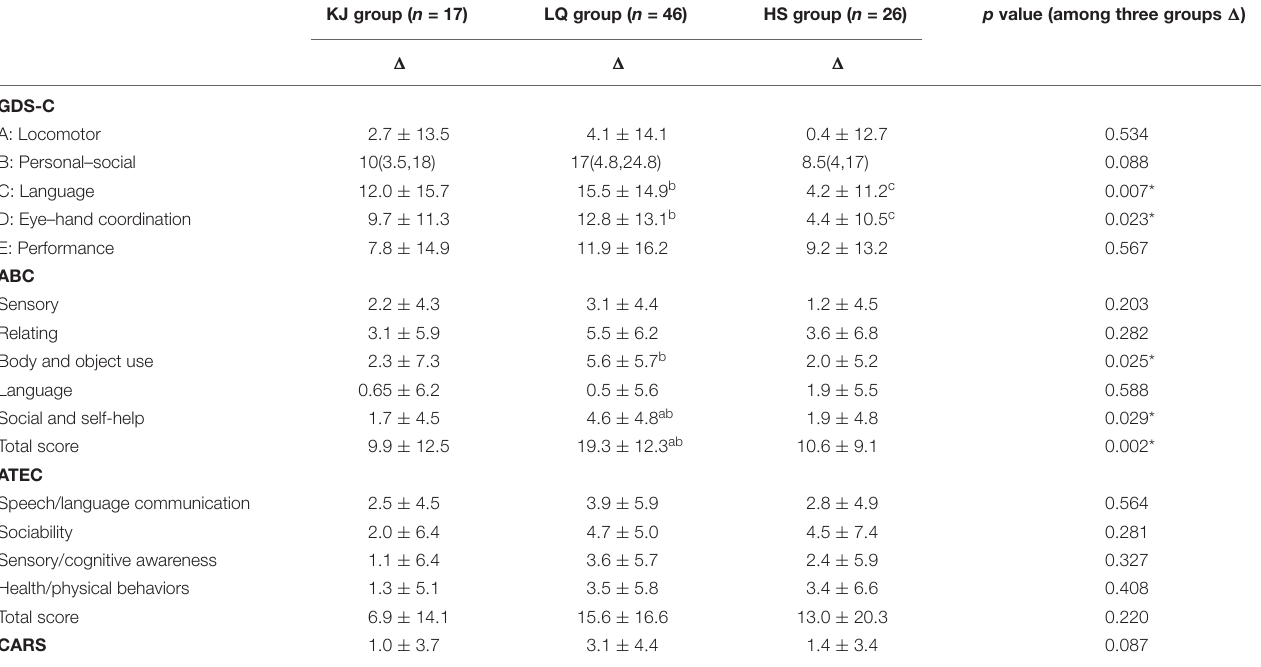
TABLE 4 | Comparison of (cid:49) GDS-C, (cid:49) ABC, (cid:49) CARS, and (cid:49) ATEC between the three groups after 3 months of treatment. KJ group ( n = 17) LQ group ( n = 46) HS group ( n = 26) p value (among three groups (cid:49)